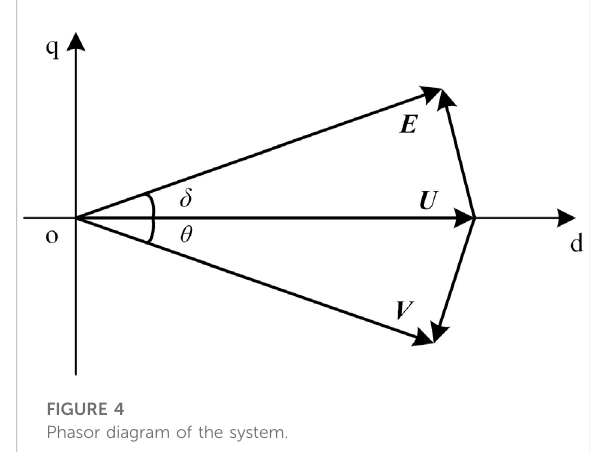
FIGURE 4 Phasor diagram of the